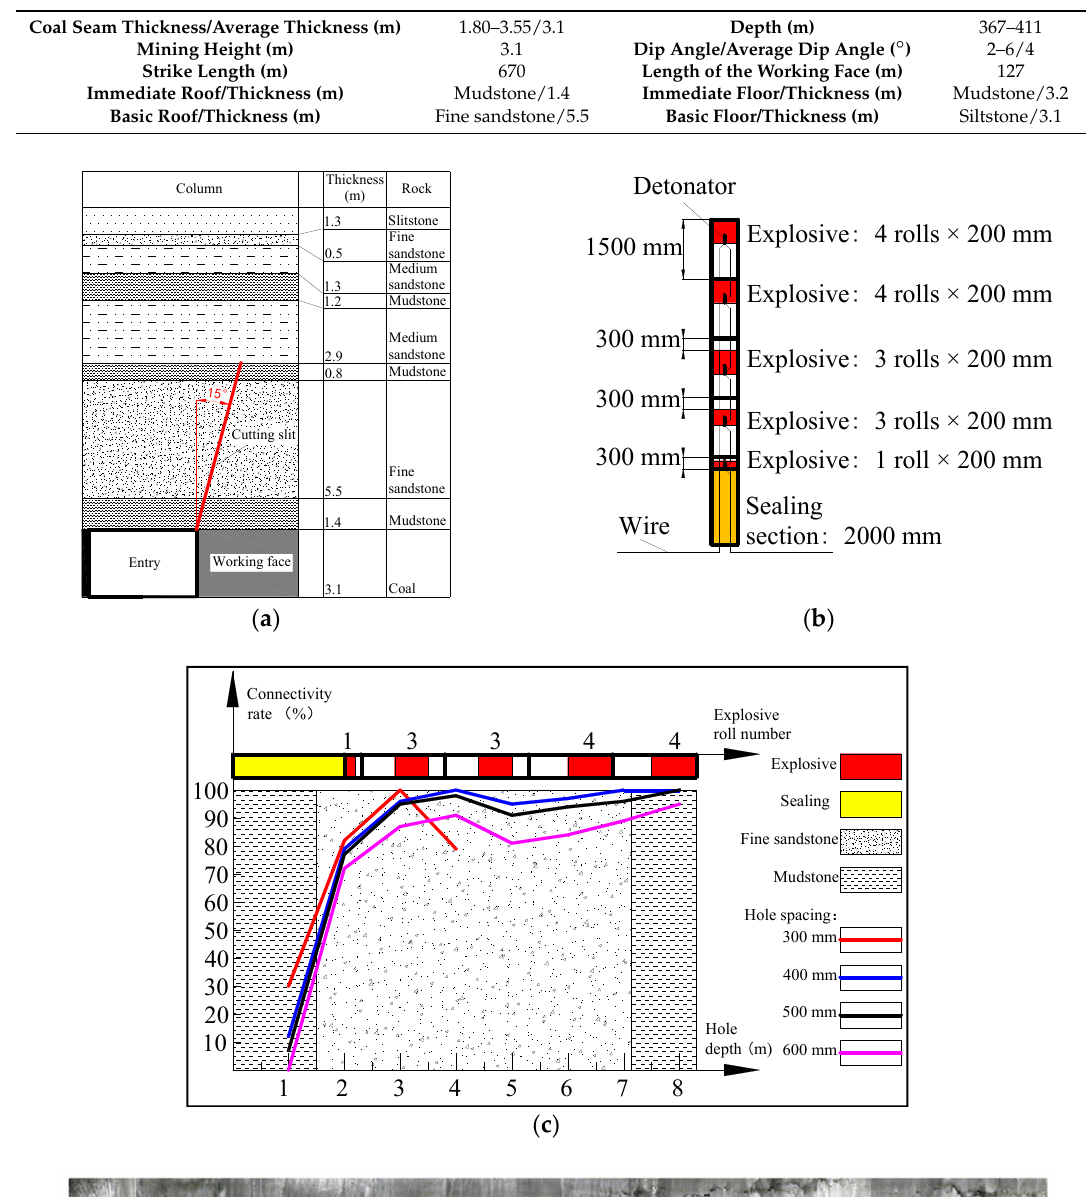
Table 1. Basic parameters of the 8304 working face in the Tashan Coal Mine.